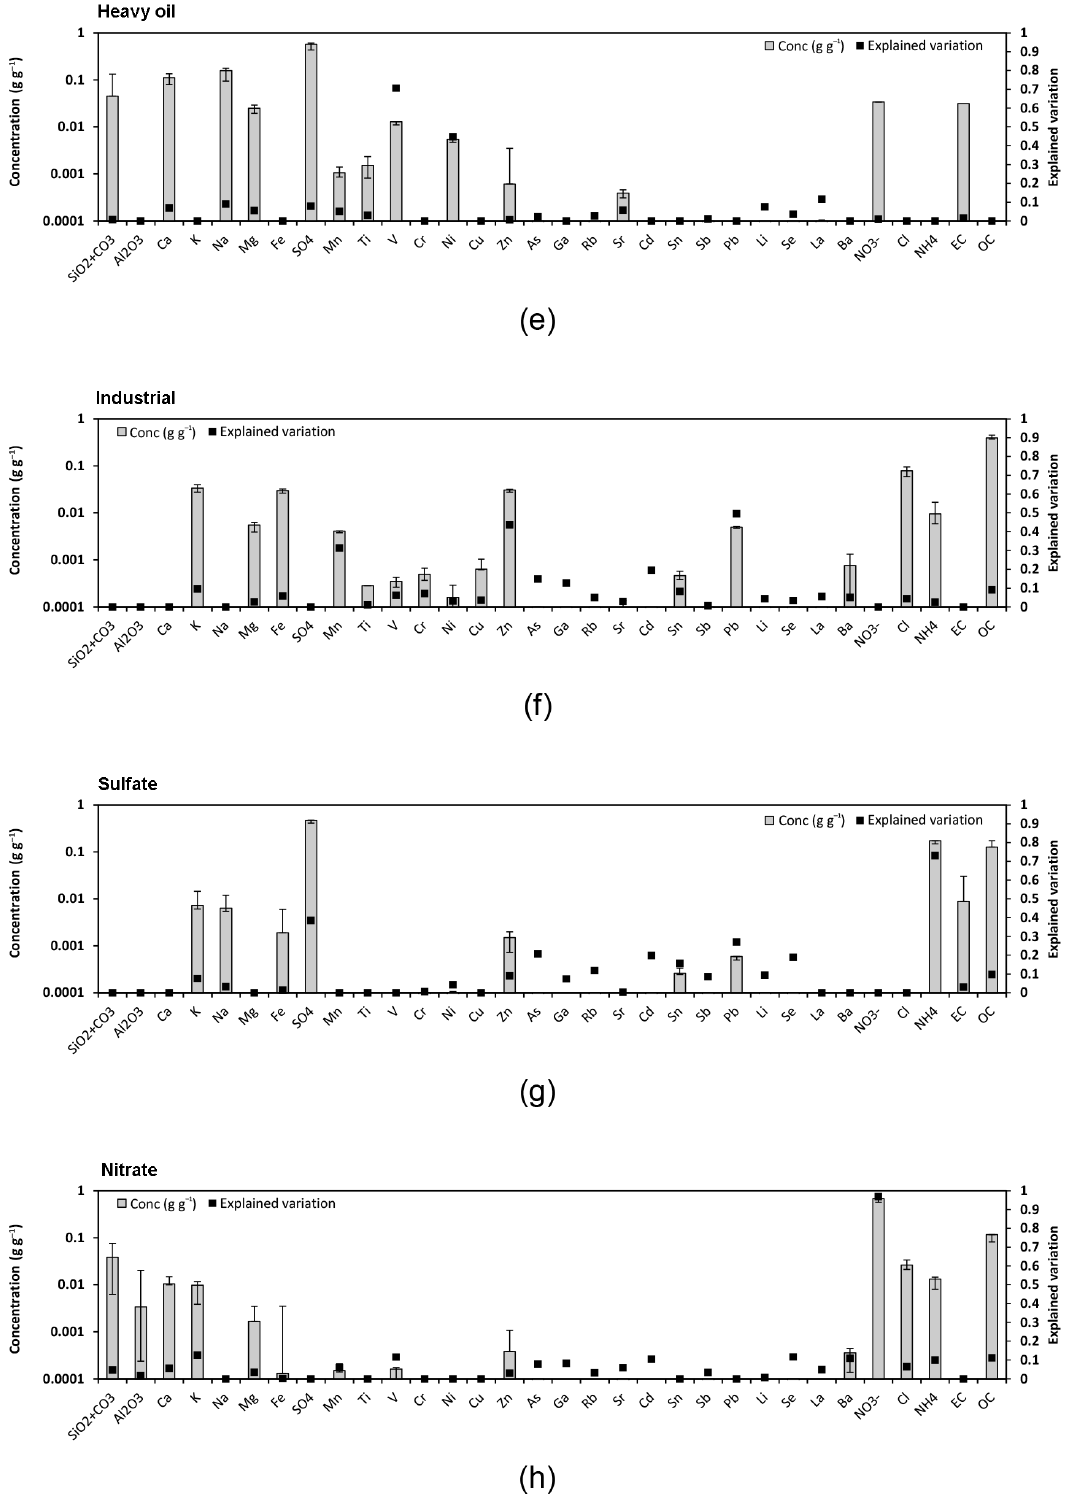
Figure 4. PMF sources profiles for PM 10 during the SAPUSS campaign: (a) vehicle exhaust and wear, (b) road dust, (c) mineral, (d) aged marine, (e) heavy oil, (f) industrial, (g) sulfate, (h) nitrate. Uncertainties were obtained by